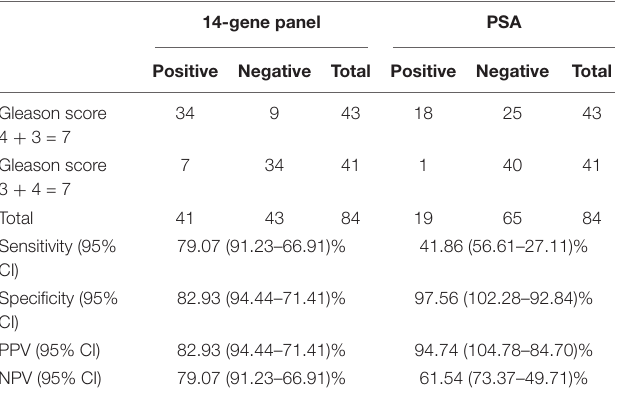
TABLE 5 | Sensitivity, specificity, PPV, and NPV of 4-Gene-Panel and PSA to distinguish the two subgroups of Gleason score 7 patients in a prospective PCa urine cohort.